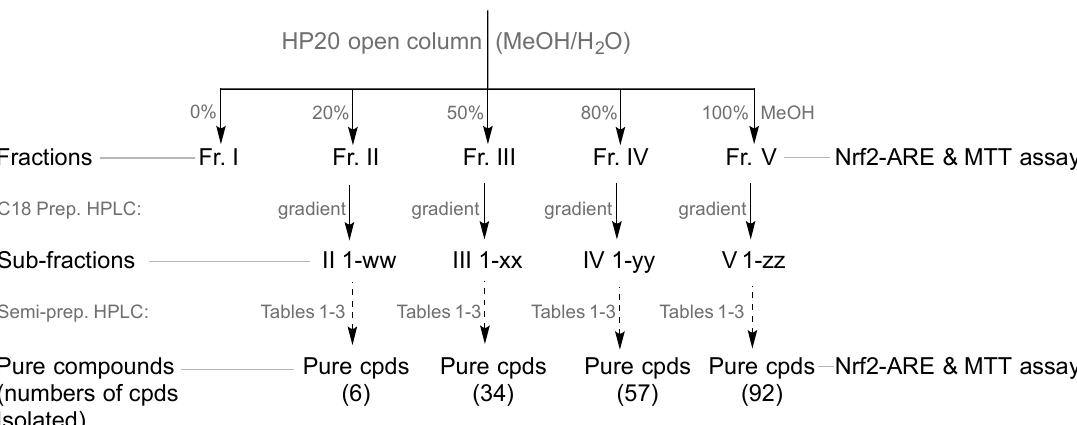
Scheme 1. Flow chart of experimental design and numbers of pure compounds isolated from fractions II–V (See Tables 1–3 for retention times of the 189 pure compounds and high performance liquid chromatography (HPLC) conditions including columns, flow-rates, and solvent systems).